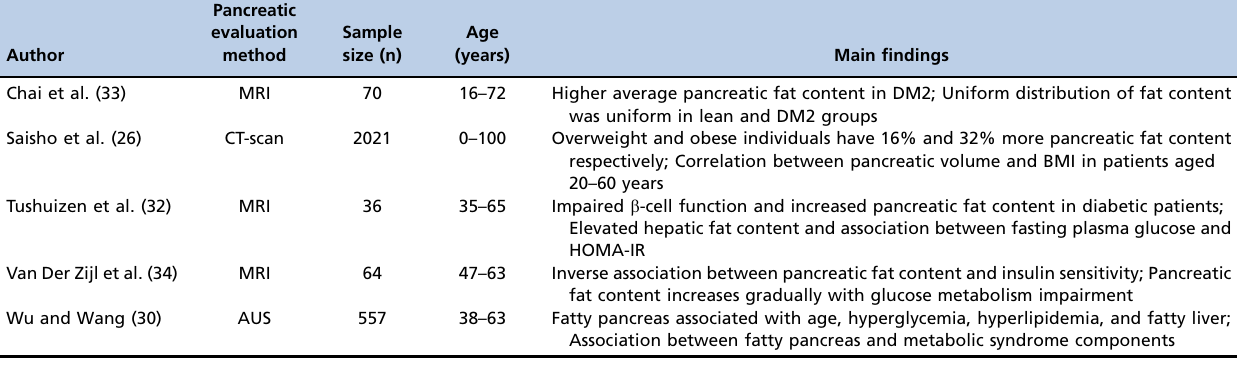
Table 1 - Characteristics of studies evaluating pancreatic-associated diseases included in the present review.